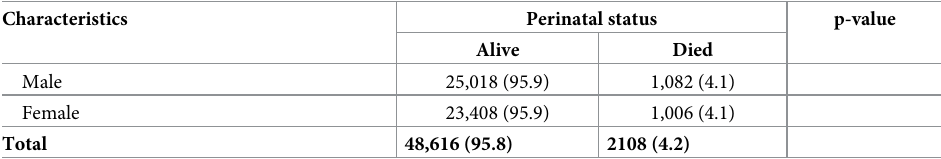
PLOS ONE | https://doi.org/10.1371/journal.pone.0231636 April 16,